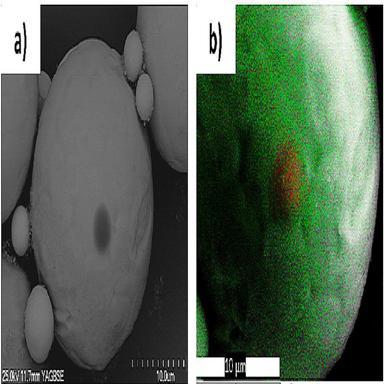
Image showing a) the SEM image and b) the EDX mapping of the spherical particles with a relatively smooth surface; the green color corresponds to Ni and the red color to Al. (For interpretation of the references to color in this figure legend, the reader is referred to the web version of this article.)